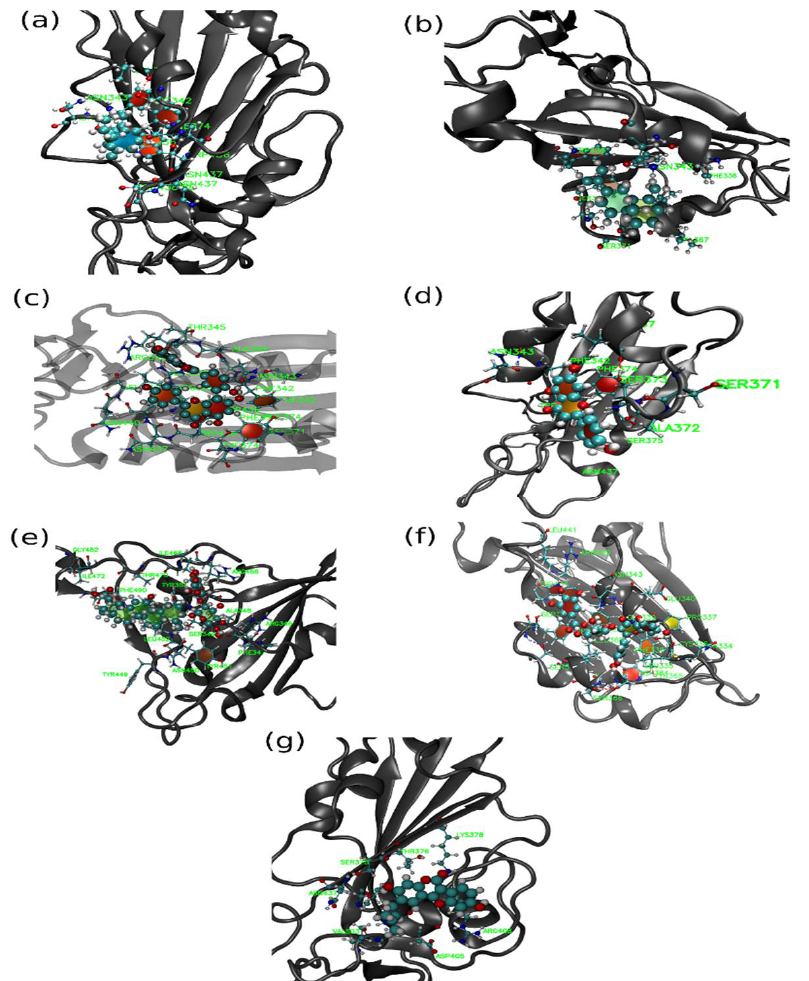
Figure 9. Representative snapshot of protein with ( a ) ALR, ( b ) ALS, ( c ) AMN, ( d ) APG, ( e ) GLR, ( f ) MYG and ( g ) PSR ligands. Here, solid spheres represent drug molecules, CPK model represents residues of protein, which are within 5 Å of the ligand and cartoon (grey) representation for protein.